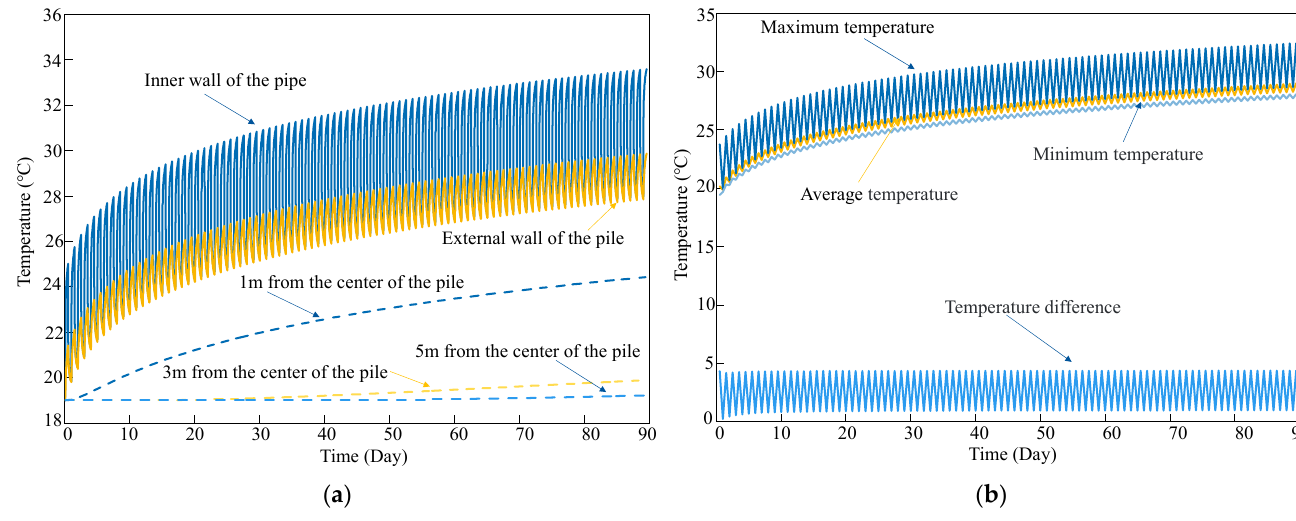
Figure 8. Temperature at different locations and the average temperature of the pile under intermittent working conditions in summer. ( a ) Temperature at different locations. ( b ) The average temperature of the pile.